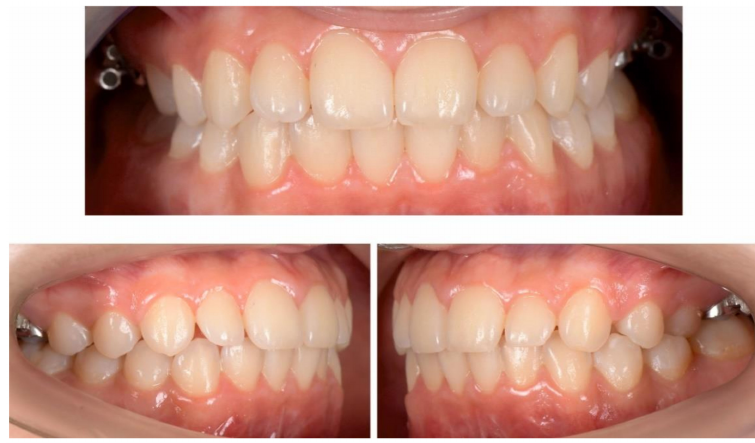
Figure 21. Intra-oral aspect at the end of